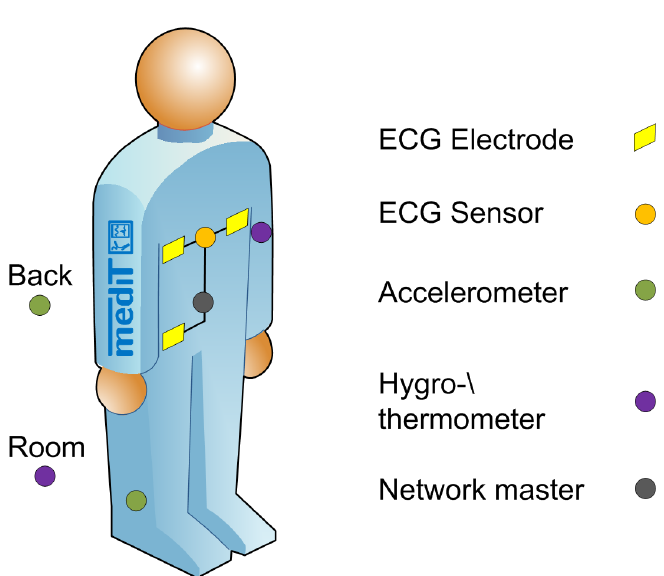
Figure 7. Position of the IPANEMA generation 2.5 sensor nodes on the